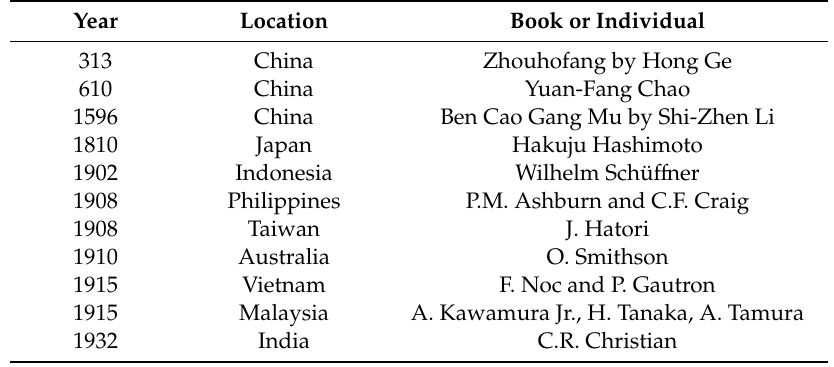
Table 1. Early History of Scrub Typhus.